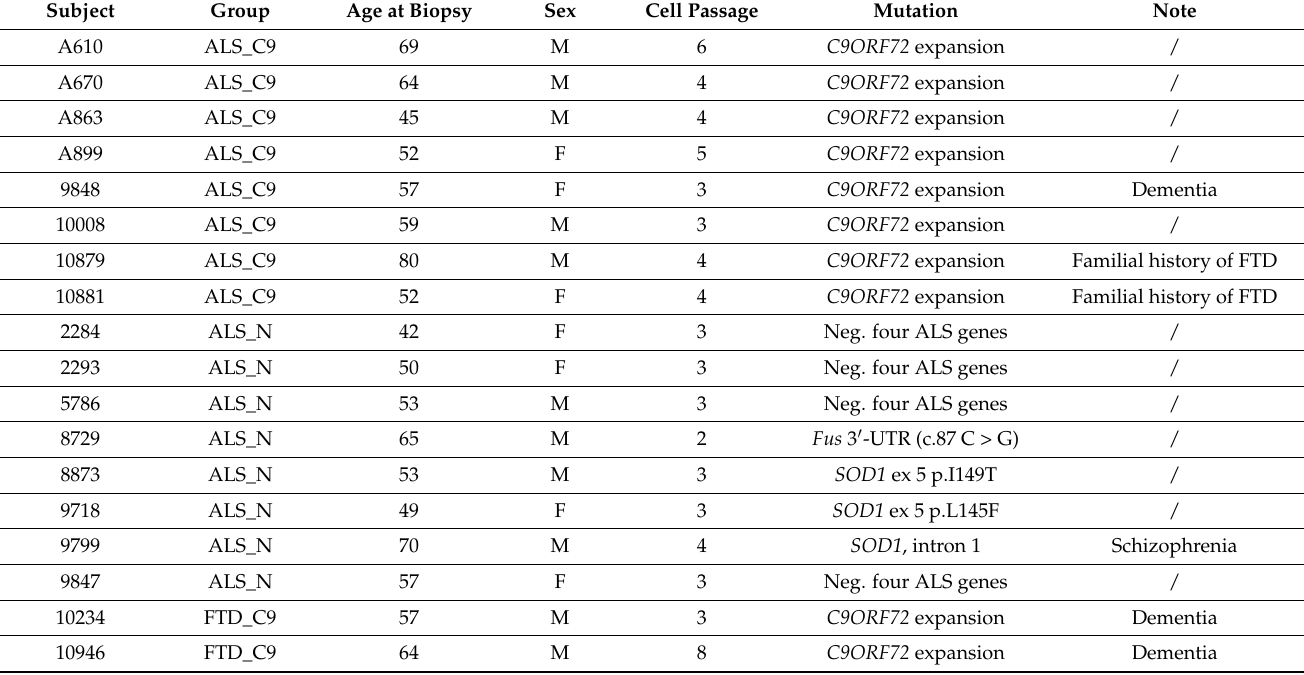
Table 1. Outline of primary skin fibroblast samples from ALS and FTD